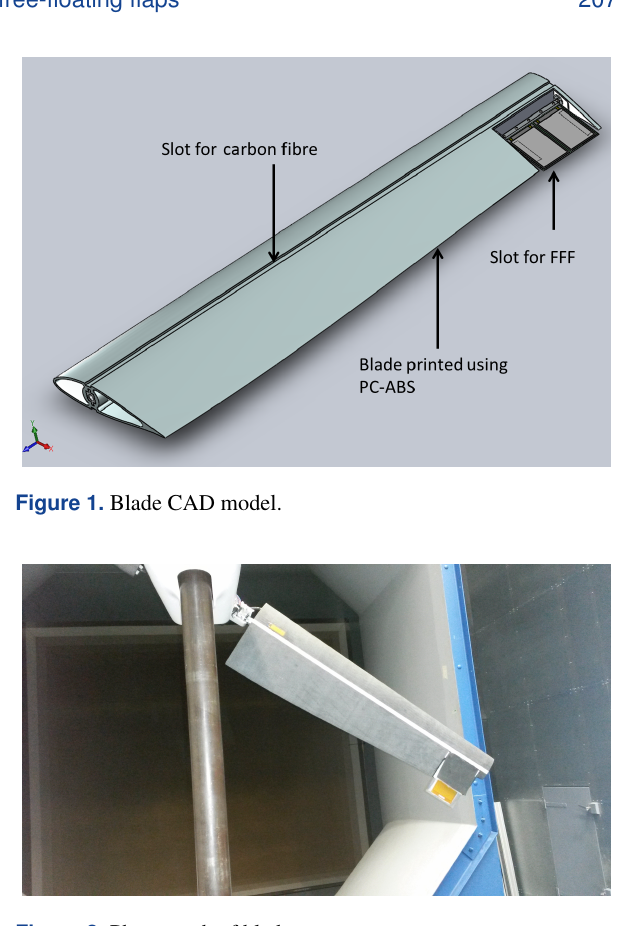
Figure 2. Photograph of